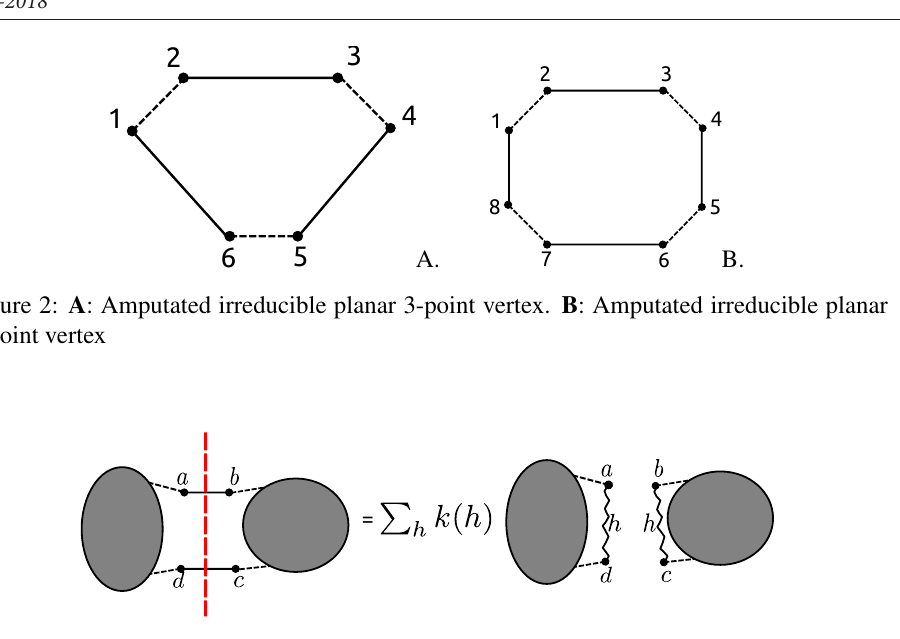
Figure 3: Graphical representation of the reduction formula for planar irreducible